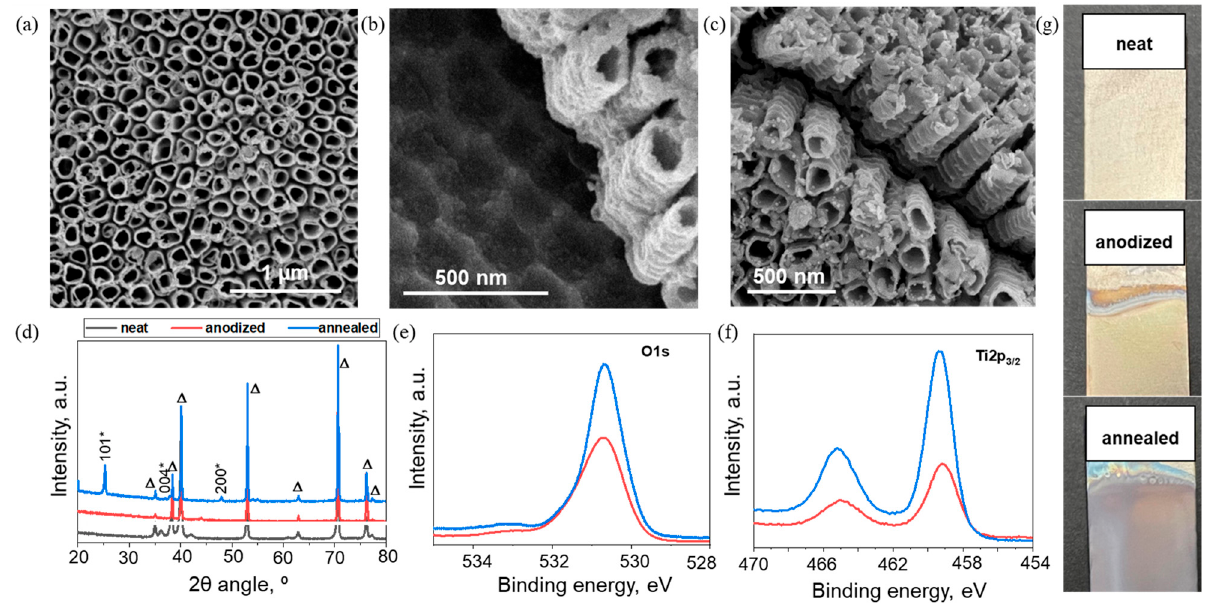
Figure 1. SEM images of ( a ) the top surface of annTNA (scale bar 1 µm) and ( b ) the tube length and bottom surface after etching (scale bar 500 nm), and ( c ) the uniform height of nanotubes (scale bar 500 nm) visualized by a custom scratch on the TNA surface. ( d ) XRD analysis of anoTNA and annTNA; the indices ‘*’ and ‘ Δ ’ represent the anatase phase and the rutile phase, respectively. XPS spectra of ( e ) O1s and ( f ) Ti 2p 3/2 of anoTNA and annTNA. ( g ) Photographs of bare Ti film (neat) and Ti film after the anodization and annealing steps.